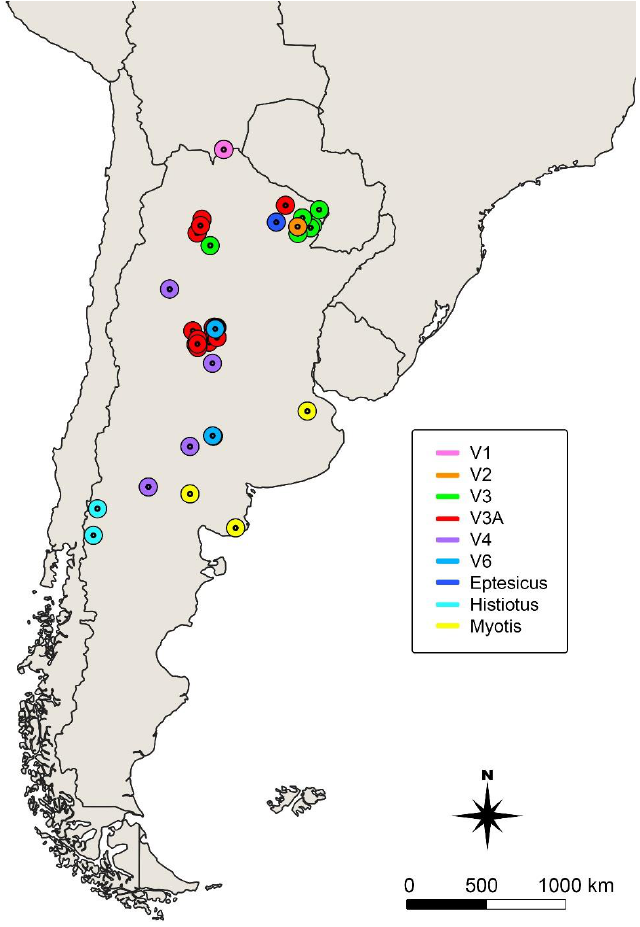
Figure 1. Map of Argentina, showing sampling localities. Colors indicate rabies virus (RABV) genetic variants.